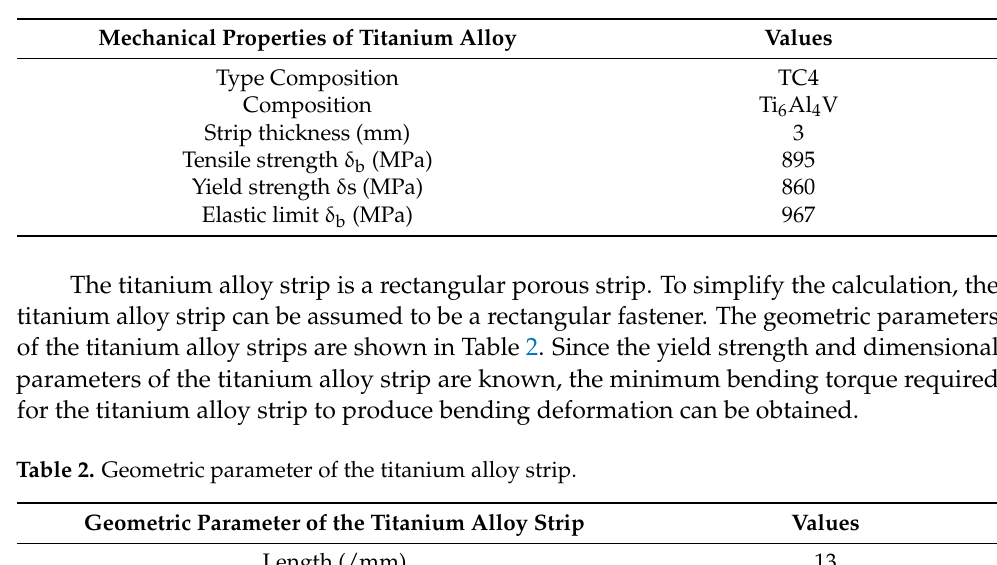
Figure 3. The position of the bending origin point. Table 1. Mechanical properties of titanium alloy at room temperature.